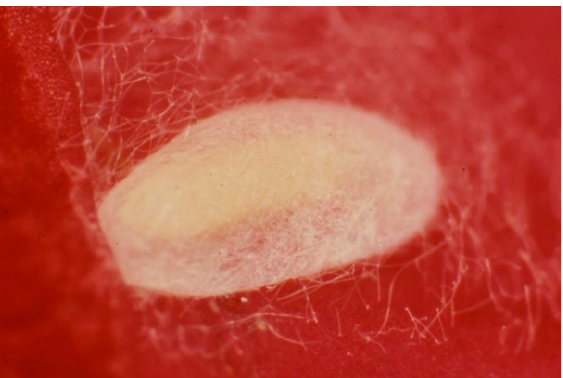
Figure 4. Cocoon of the predatory thrips Aeolothrips intermedius (Photo by R. Antonelli).